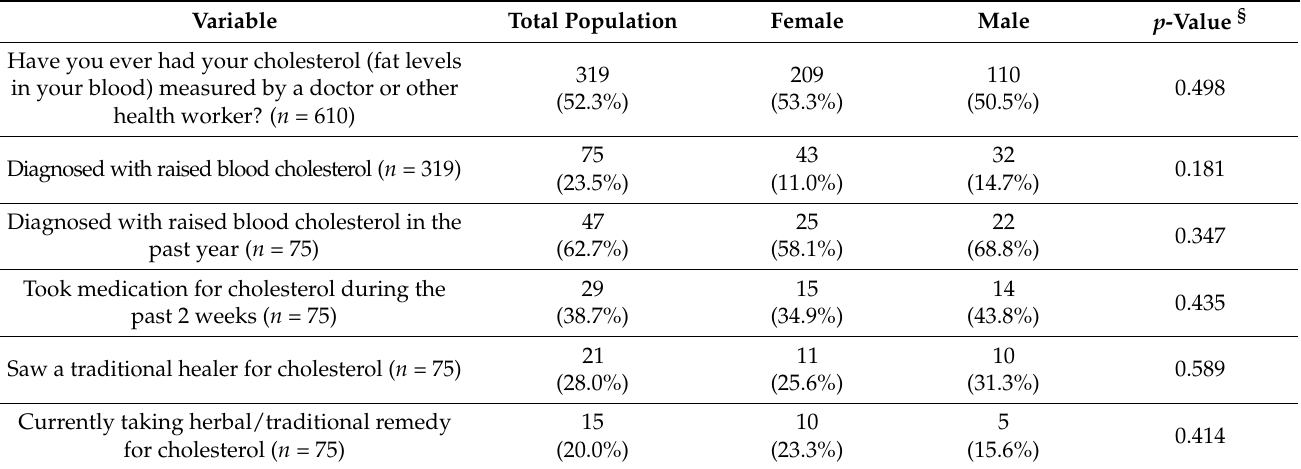
Table 2. Diagnosis and treatment of dyslipidemia by